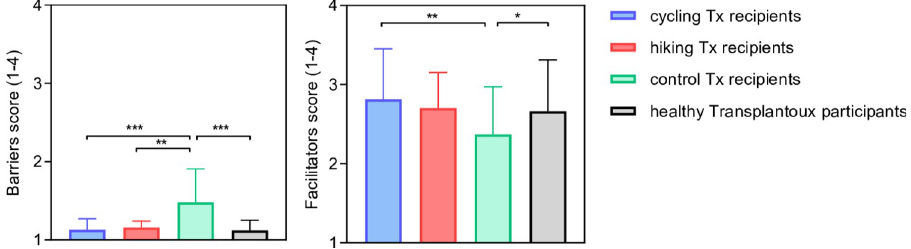
Fig 6. Barriers and facilitators to physical activity for each group at the end of the study. Bar graphs are mean ± SD. ��� P < 0.001, �� P < 0.01, � P <